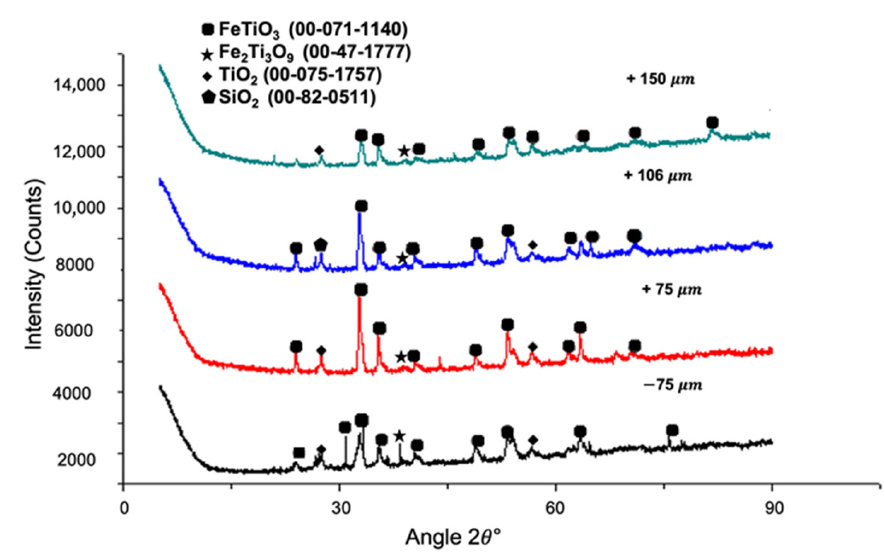
Figure 3. XRD patterns of the as-received ilmenite ore with various particle size distributions.